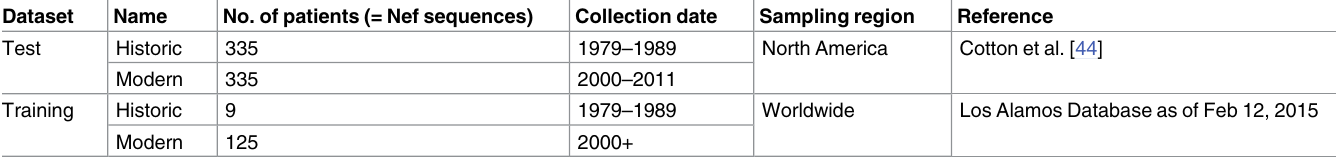
Table 1. Features of the Test and Training Datasets of Nef